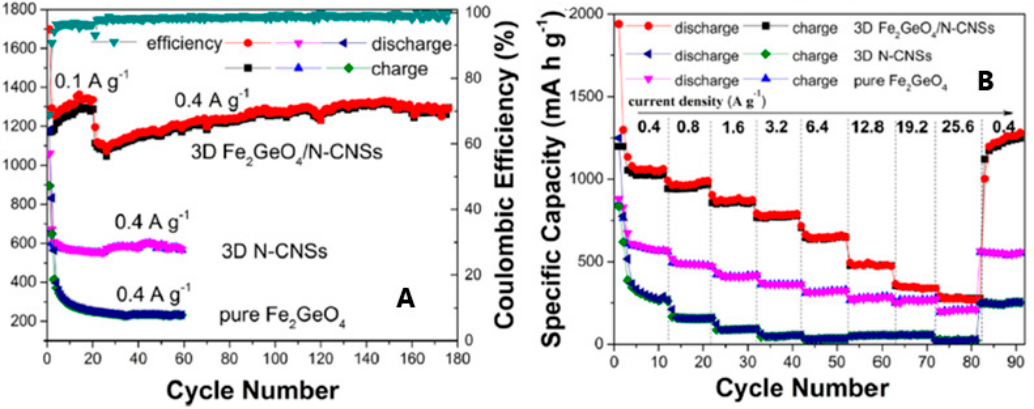
Figure 12. Cycling ( A ) and rate performances ( B ) of 3D GFO/N-CNS compared to those of 3D N-CNSs and pure GFO anodes for LIBs [31]. Reproduced with permission, Copyright Elsevier 2018. The initial specific discharge and charge capacities at a current density of 0.1 Ag − 1 were 1697.7 mAhg − 1 and 1169.8 mAhg − 1 , with a CE of about 68.9%, due to the irreversible 94.3% at the third cycle but was about 99.4% during the subsequent cycling. In contrast,